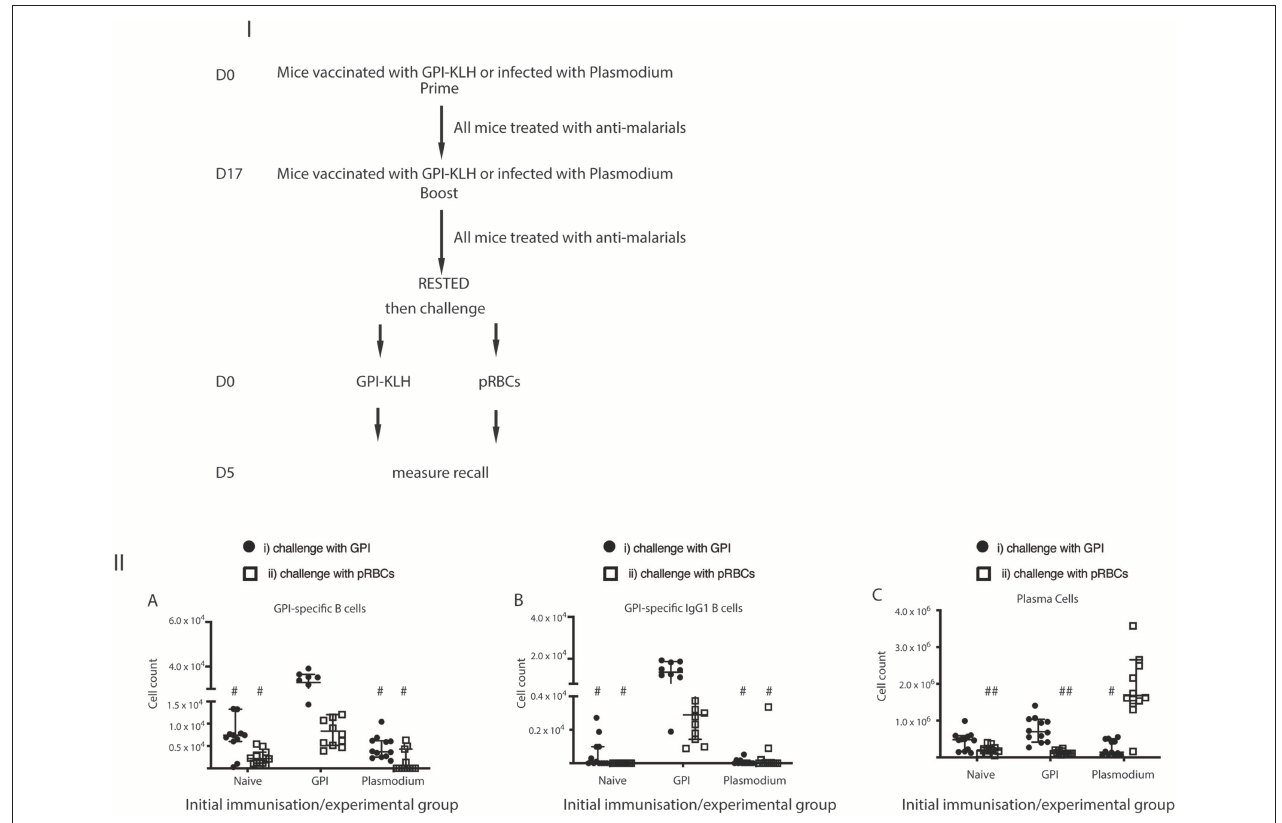
FIGURE 4 | Challenge with synthetic GPI-KLH or pRBCs induced rapid activation of GPI-specific MBCs in previously GPI-vaccinated mice, whilst Plasmodium mice do not generate GPI-specific MBC. Mice were vaccinated and boosted with GPI-KLH ( n = 24) or infected twice with pRBCs i.p . ( n = 24, referred to as Plasmodium mice). Naïve mice were included as a control group ( n = 24). After resting for a minimum of 10 weeks, mice were injected with GPI-KLH i.p. (closed circles; n = 12 from each group) or 1 × 10 5 pRBCs i.p. (open squares; n = 12 from each group) to assess reactivation of MBCs at day 5. Panel (I) outlines experimental design. Panel (II) is the analysis of activated B cell populations for the number of cells per spleen for (A) GPI-specific B cells, (B) GPI-specific IgG1 B cells, and, (C) Plasma Cells at day 5. Experiments were reproduced independently thrice. Pooled data from all mice from all 3 experiments are represented as median ± 95%-CI. Data was analyzed using the non-parametric Kruskal-Wallis test and differences determined by Dunn’s multiple comparisons test. Significance was determined at P < 0.05. (A,B) # when challenged with GPI-KLH or pRBCs, the initial experimental groups of naïve mice and Plasmodium mice were significantly lower than GPI-KLH mice ( P < 0.05). (C) # when challenged with GPI-KLH the initial experimental group of Plasmodium mice was significantly lower than the GPI-KLH mice ( P < 0.05); ## when challenged with pRBCs, the initial experimental groups of naïve and GPI-KLH mice were significantly lower than Plasmodium mice for plasma cell production ( P <